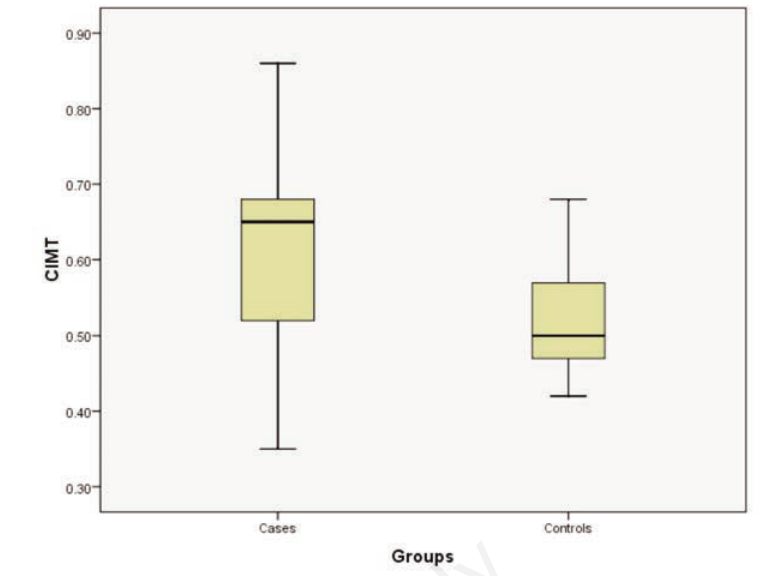
Figure 1. Mean carotid intima-media thickness (CIMT) in cases vs controls.